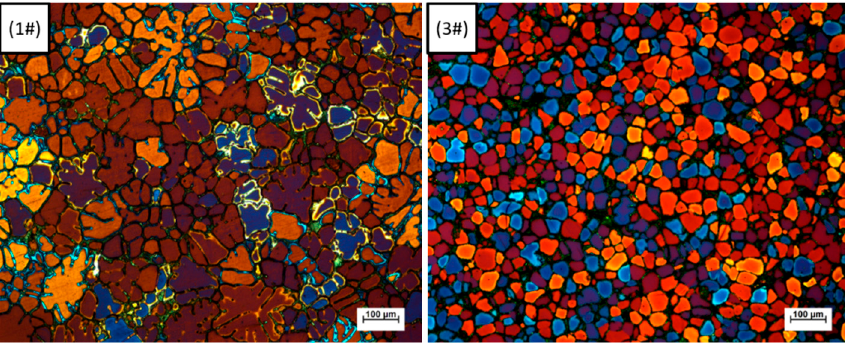
Figure 11. Color metallographic photos of the microstructure of 1# and 3# in as-cast status.